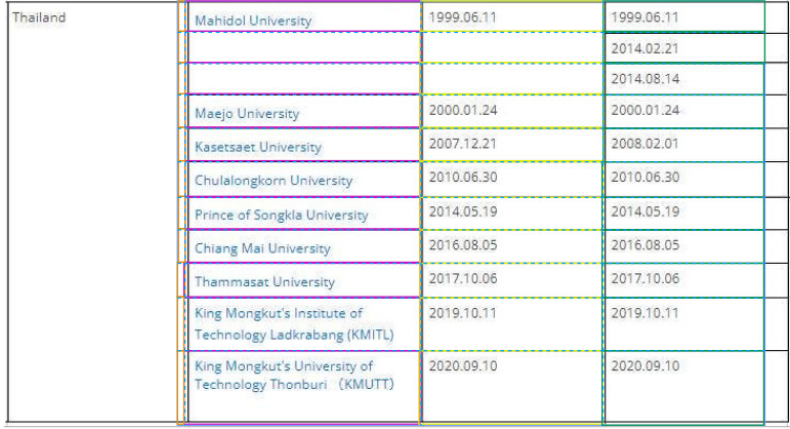
Figure 34. Result with wrong box locations